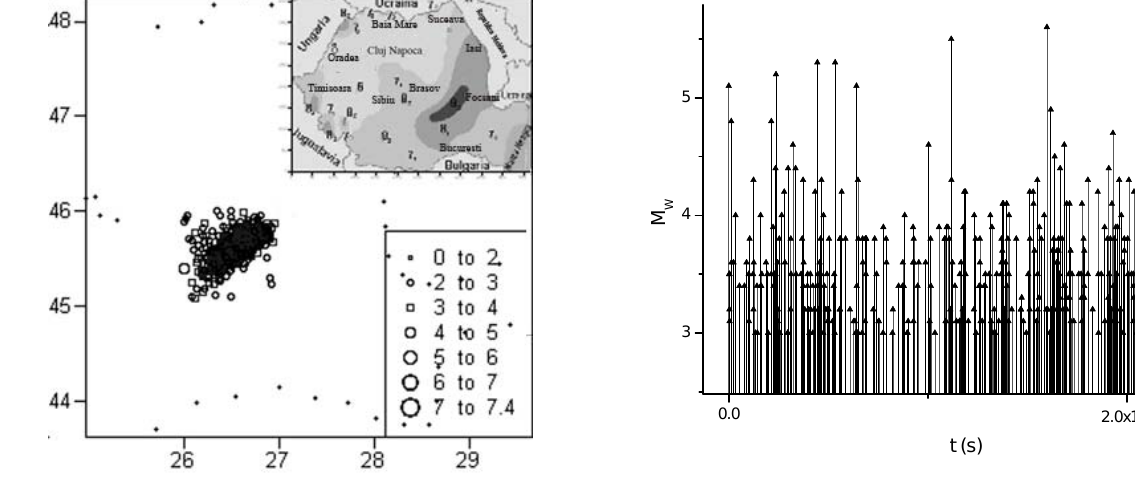
Fig. 3. Enlargement of a portion of Fig. 2.